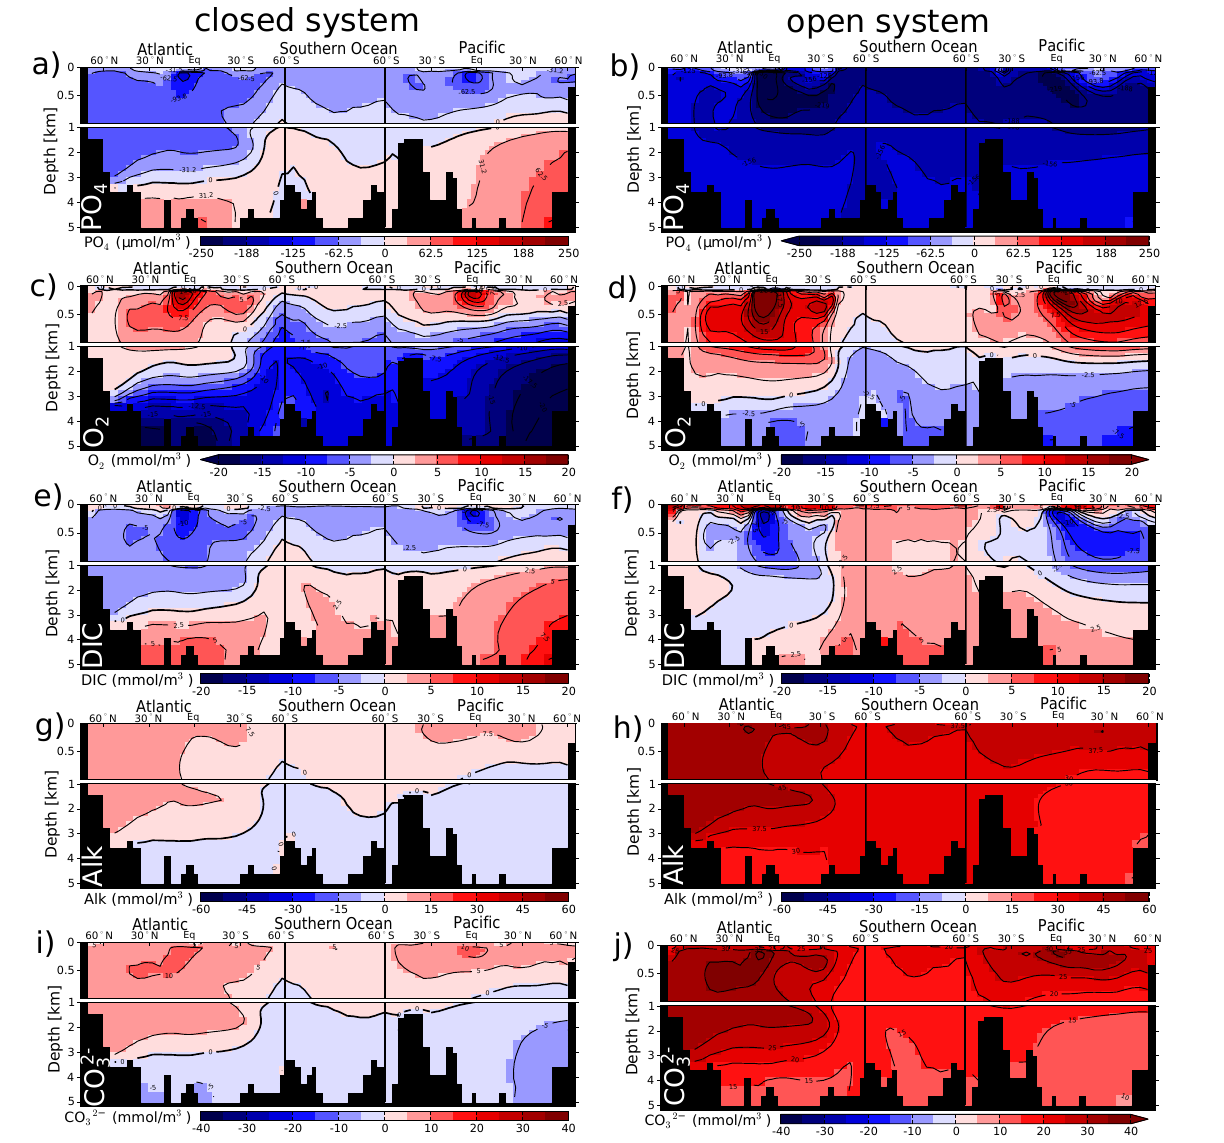
Figure 5. Equilibrium changes in annual mean tracer concentrations in a POM deepening experiment ( l POM : 250m → 275m) with prog- nostic changes in export production along a transect through the Atlantic, Southern and Pacific oceans (note that the top 1000m are enlarged w.r.t. the deep ocean). Shown are (from the top to bottom panels) changes in concentrations of phosphate, oxygen, dissolved inorganic car- bon, alkalinity and carbonate. The experiments have been run both for the closed system (left column panels) as well as for the open system (right column